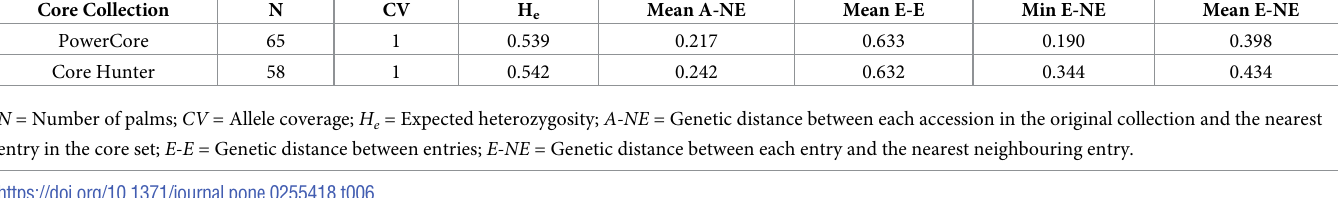
Table 6. Comparison of core collections developed using PowerCore and Core Hunter based on Bray-Curtis genetic distance measures. Core Collection